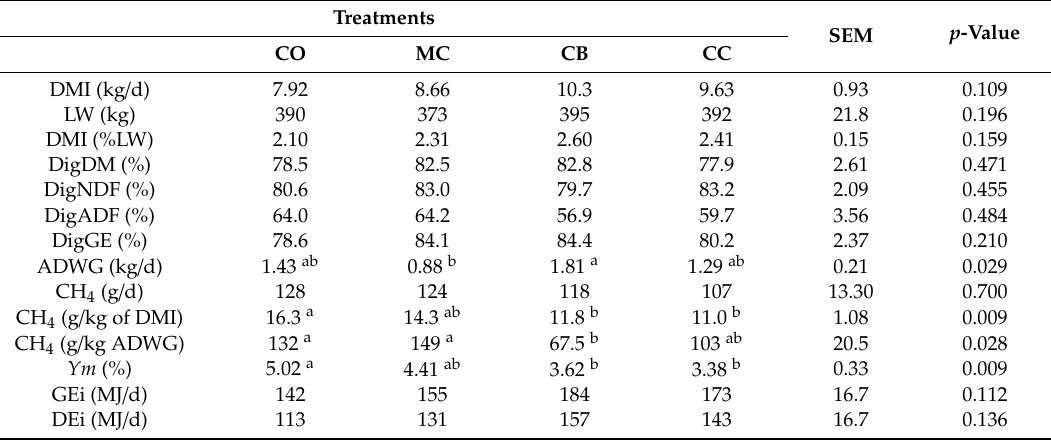
Table 2. E ff ects of Matricaria chamomilla , Cosmos bipinnatus and Cymbopogon citratus supplementation on dry matter intake, digestibility, live weight gain and methane production in F1 beef steers on a finishing diet in Experiment